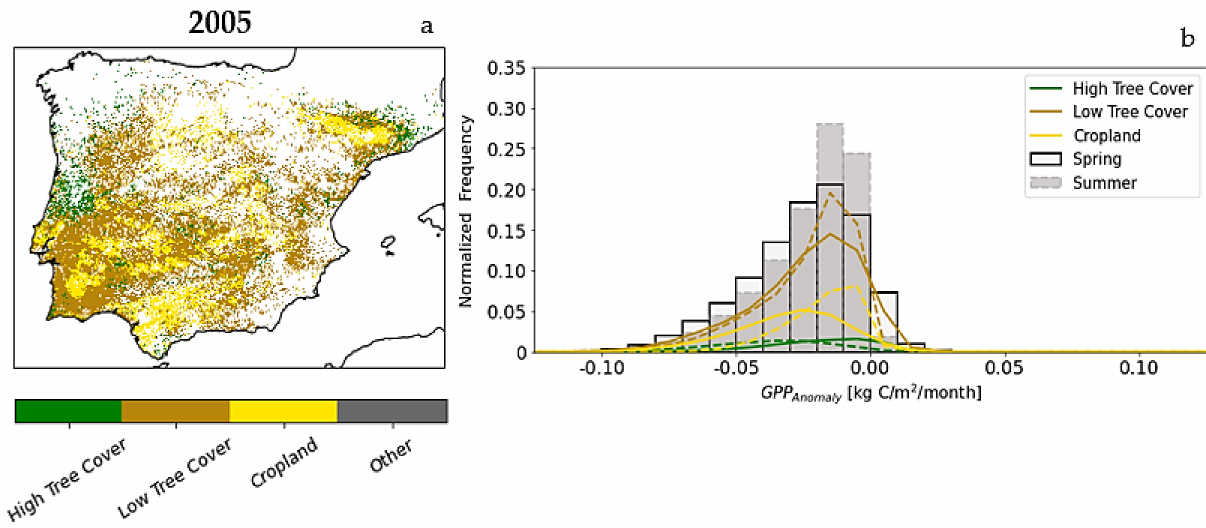
Figure 5. Impacts of 2005 on vegetation in IB: ( a ) Land cover types affected by the ecological event; ( b ) Distribution of GPP anomalies frequency for the three land cover classes during the spring (MAM) (bold lines and black bars) and summer (JJA) (dashed lines and dashed grey bars). Bars represent the sum of the normalized frequency of all land cover